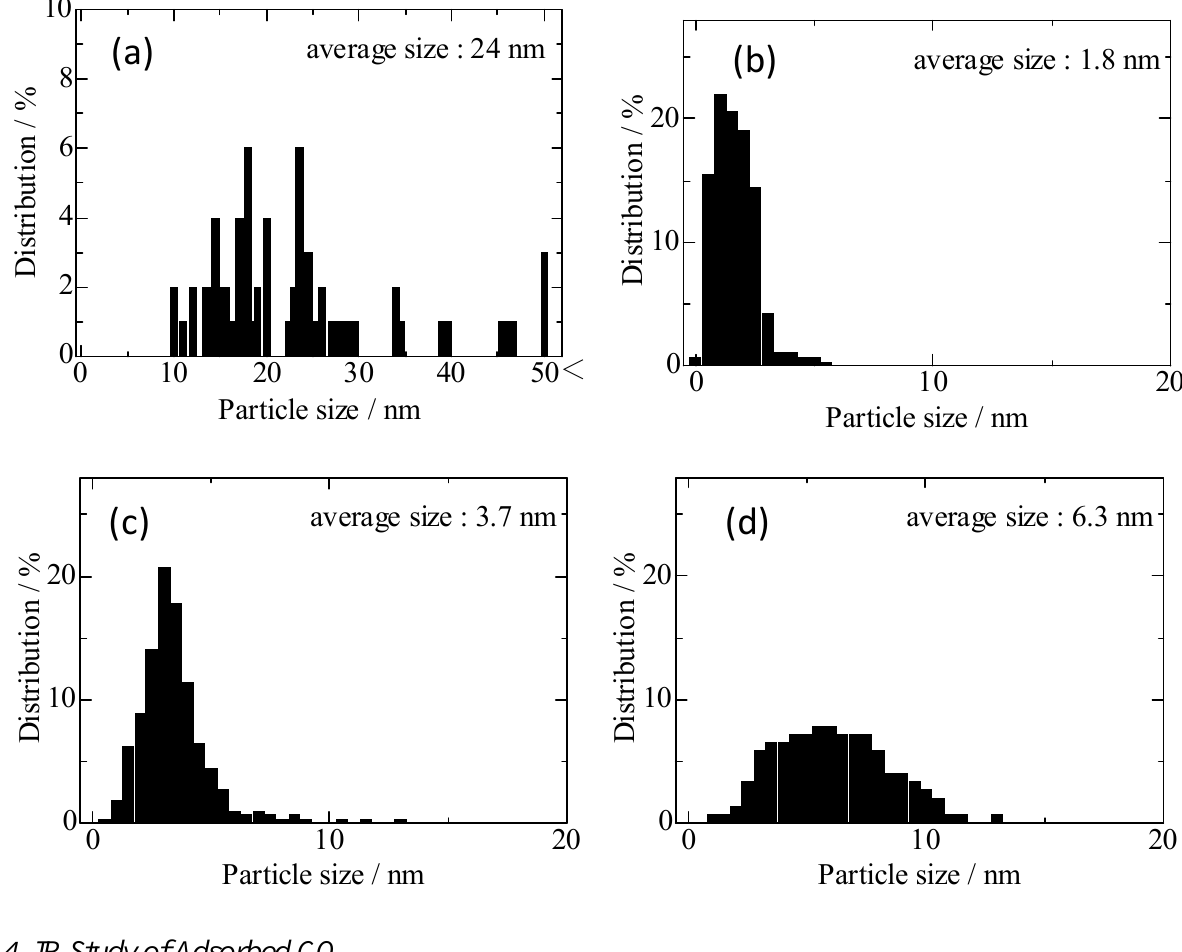
Figure 6. Distribution of Au particles in 3 wt% Au loaded on USY zeolites thermally treated in 6% H 2 diluted with Ar at ( a ) 473 K; ( b ) 773 K; ( c ) 973 K and ( d ) 1073